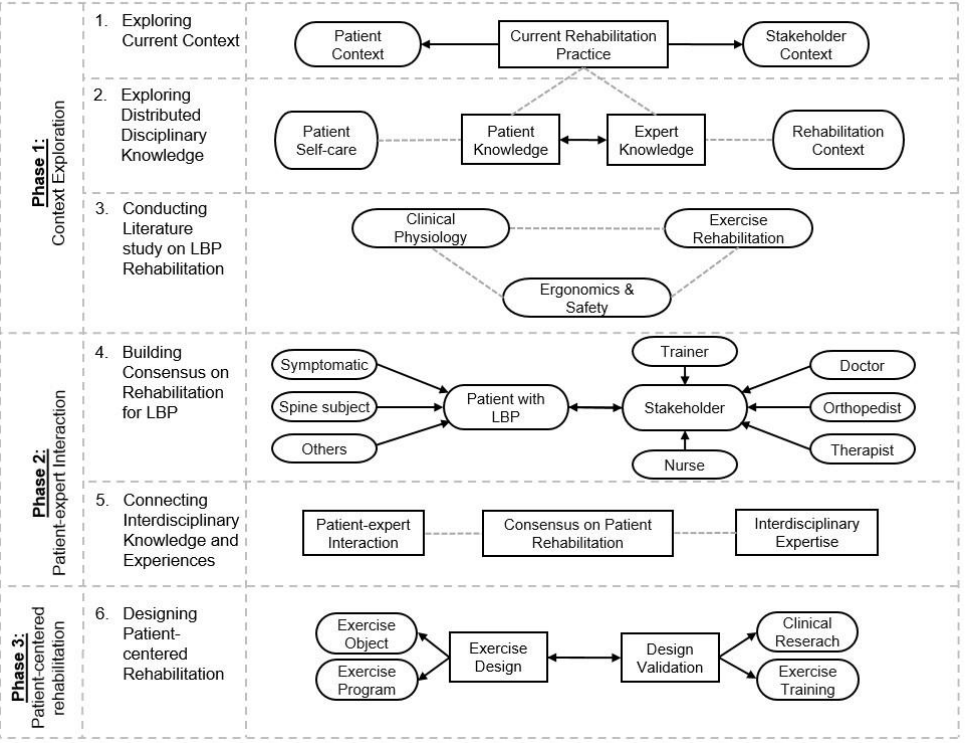
Figure 1. Schematic showing the research